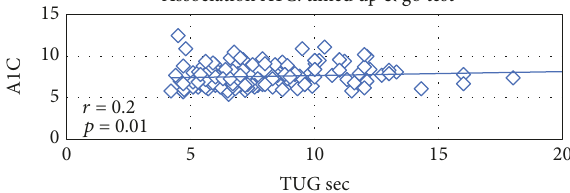
Figure 2: Association between A1C (%) and the TUG test score (sec).